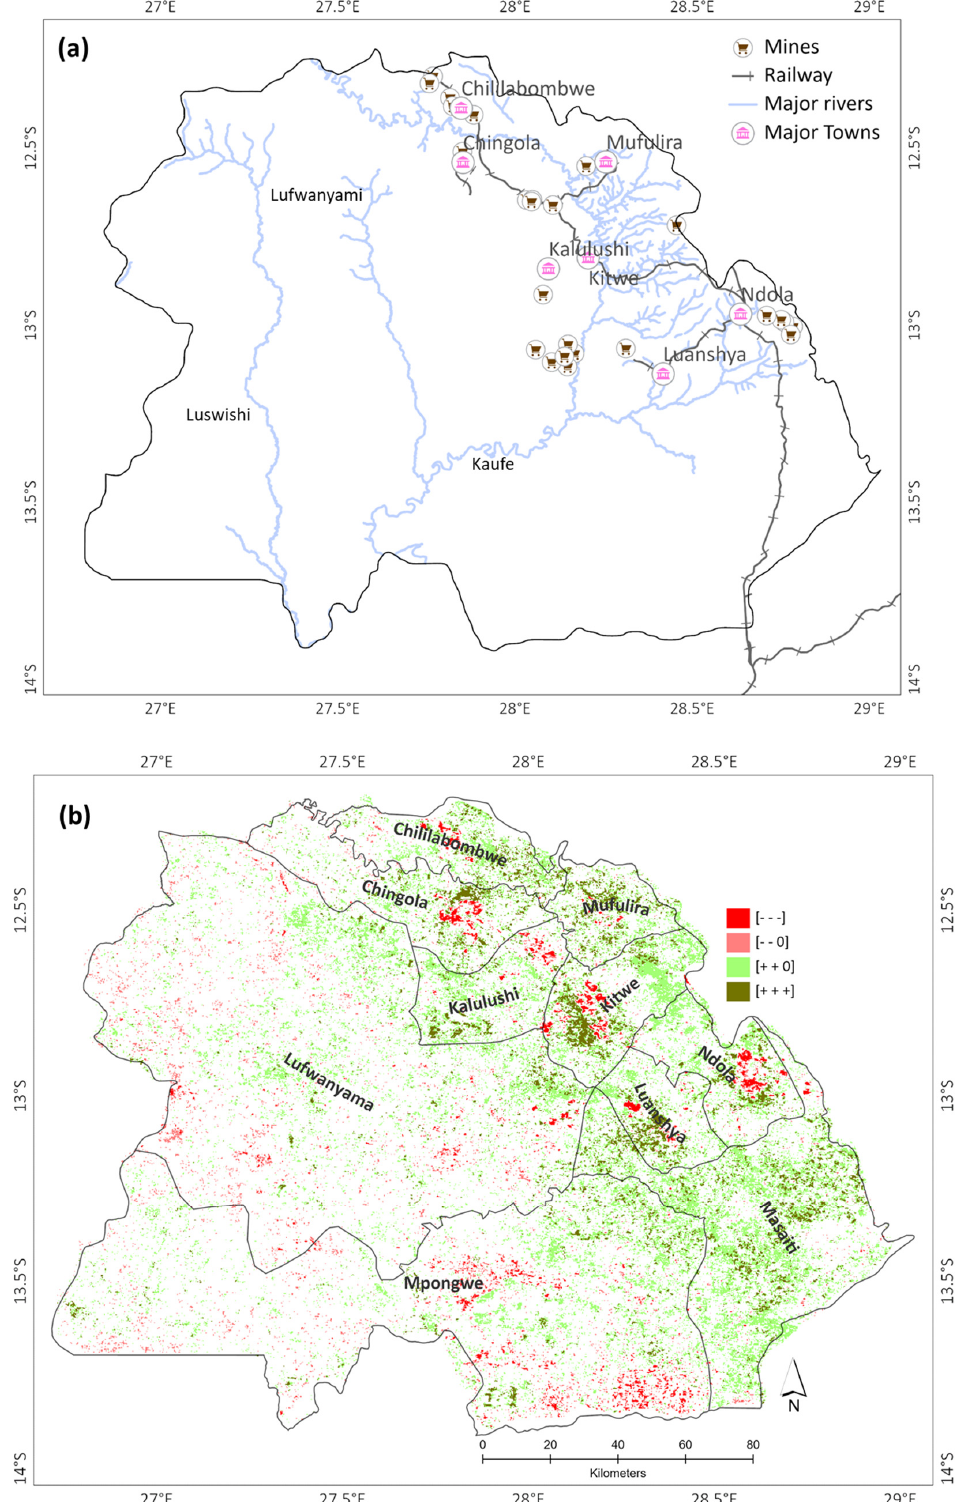
Figure 3. ( a ) Overview of major towns, railway, mines, and rivers in Copperbelt for spatial orientation. Mines were hand digitized on Google Earth, whereas railway, rivers, and towns were taken from open street map. ( b ) Spatial distribution of two and three significant trend patterns for all parameters: MGS, Peak, Harmonic combined ( b ). (-): browning, (+): greening, (0): no significant trend. According to the scale in the map, 1 cm equals 10